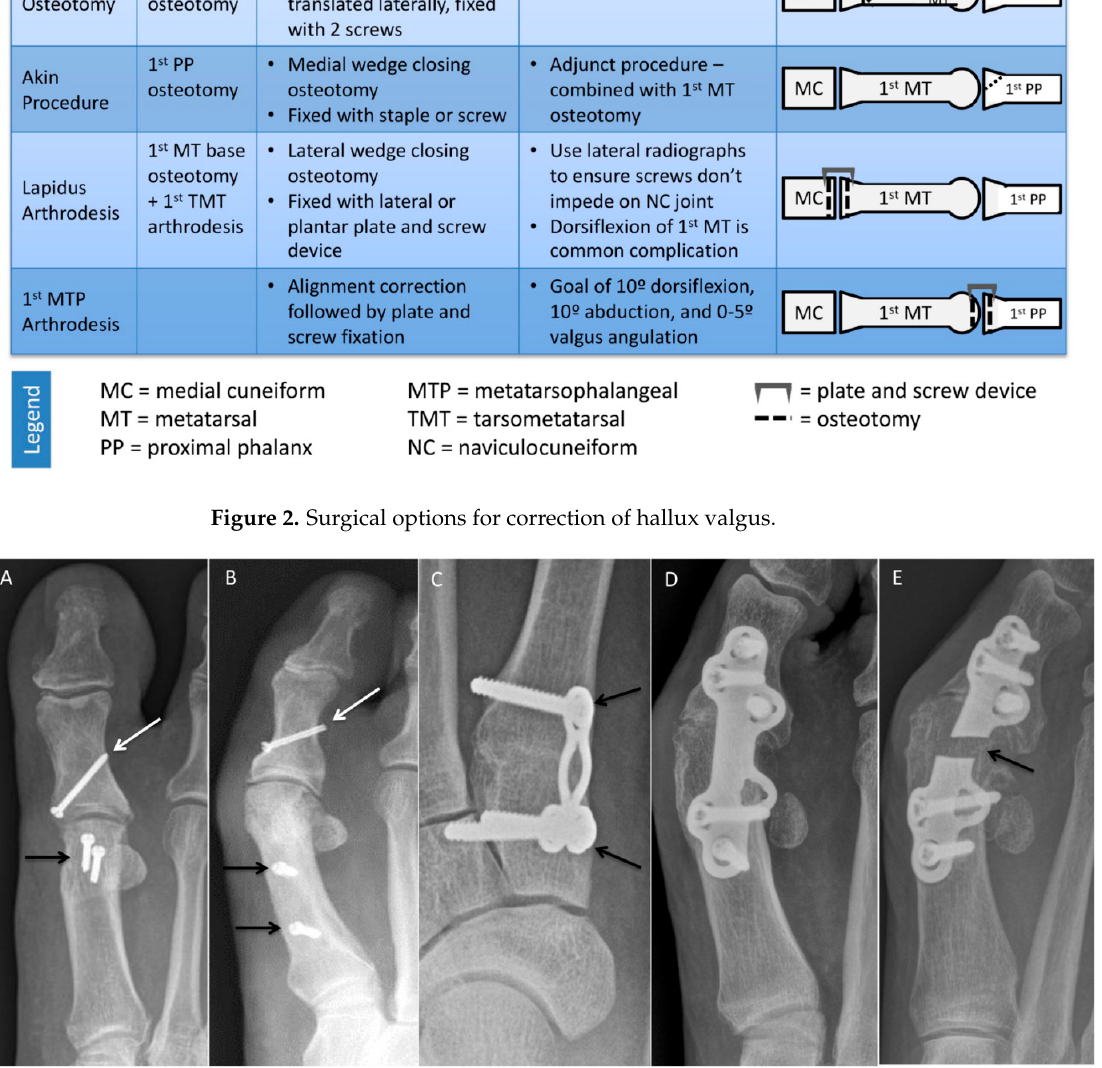
Figure 3. Hallux valgus correction. ( A ) Postoperative AP radiograph demonstrating Chevron (black arrow) and adjunct Akin (white arrow) correction of hallux valgus deformity with first metatarsal head and proximal phalangeal base osteotomies. Two first-metatarsal head screws and one screw in the base of the first proximal phalanx transfix the osteotomy sites. ( B ) Postoperative AP radiograph demonstrating Scarf (black arrows) and adjunct Akin (white arrow) correction of hallux valgus deformity with first-metatarsal shaft and proximal phalangeal base osteotomies. ( C ) Postoperative changes related to Lapidus procedure with first-metatarsal base osteotomy and first TMT arthrodesis (black arrows). ( D ) First MTP arthrodesis for correction of hallux valgus. ( E ) Postoperative complication of first MTP arthrodesis with fractured plate (black